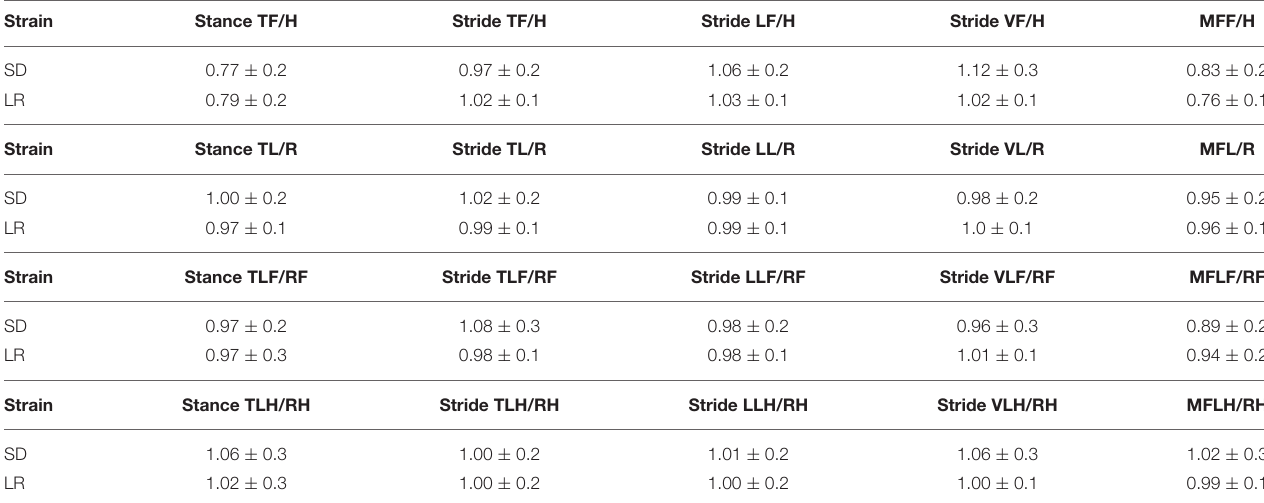
TABLE 1 | Ratio values for normalized temporal